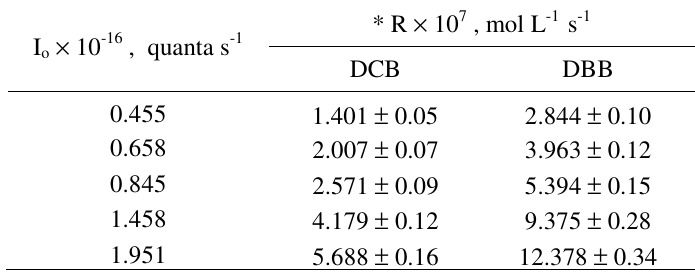
Table 3. Effect of I o on the rate of photodecomposition of DCB and DBB in aqueous acetic acid